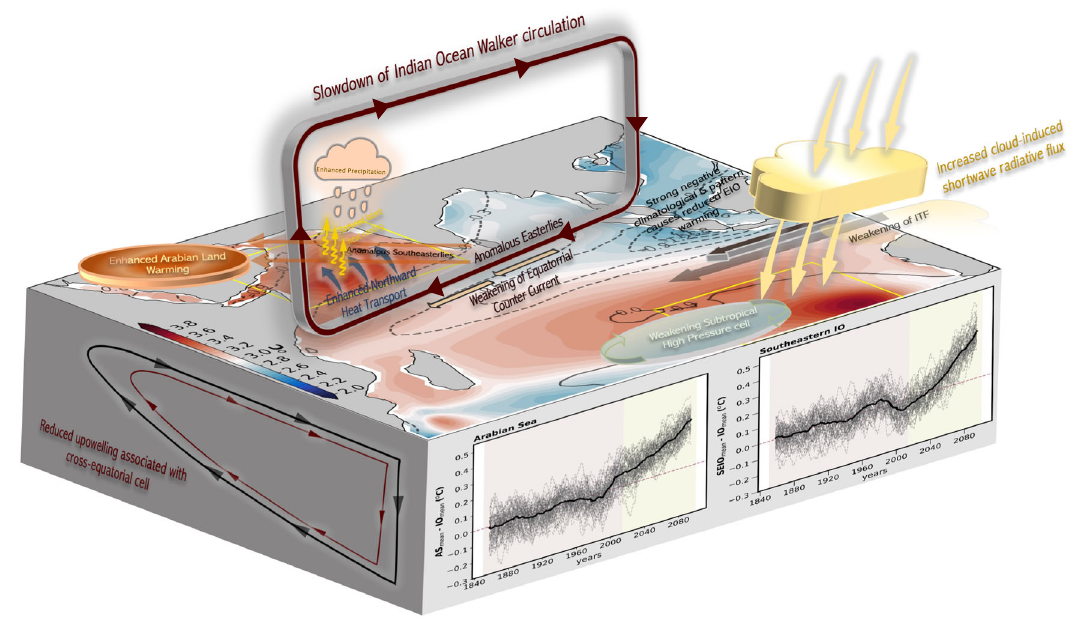
running mean time series of the SST from 1850 – 2100 for 50 ensemble members (thin) and ensemble mean (thick) over the AS (5°N:22°N, 50°E:75°E) and SEIO (35°S:20°S, 85°E:105°E). Each of the physical process accountable for forced warming patterns over the AS and SEIO are